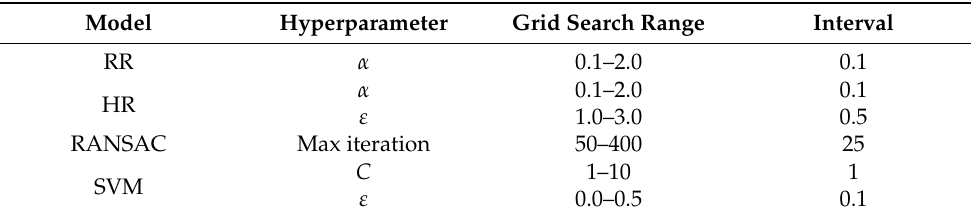
Table 3. Grid search range for hyperparameters.